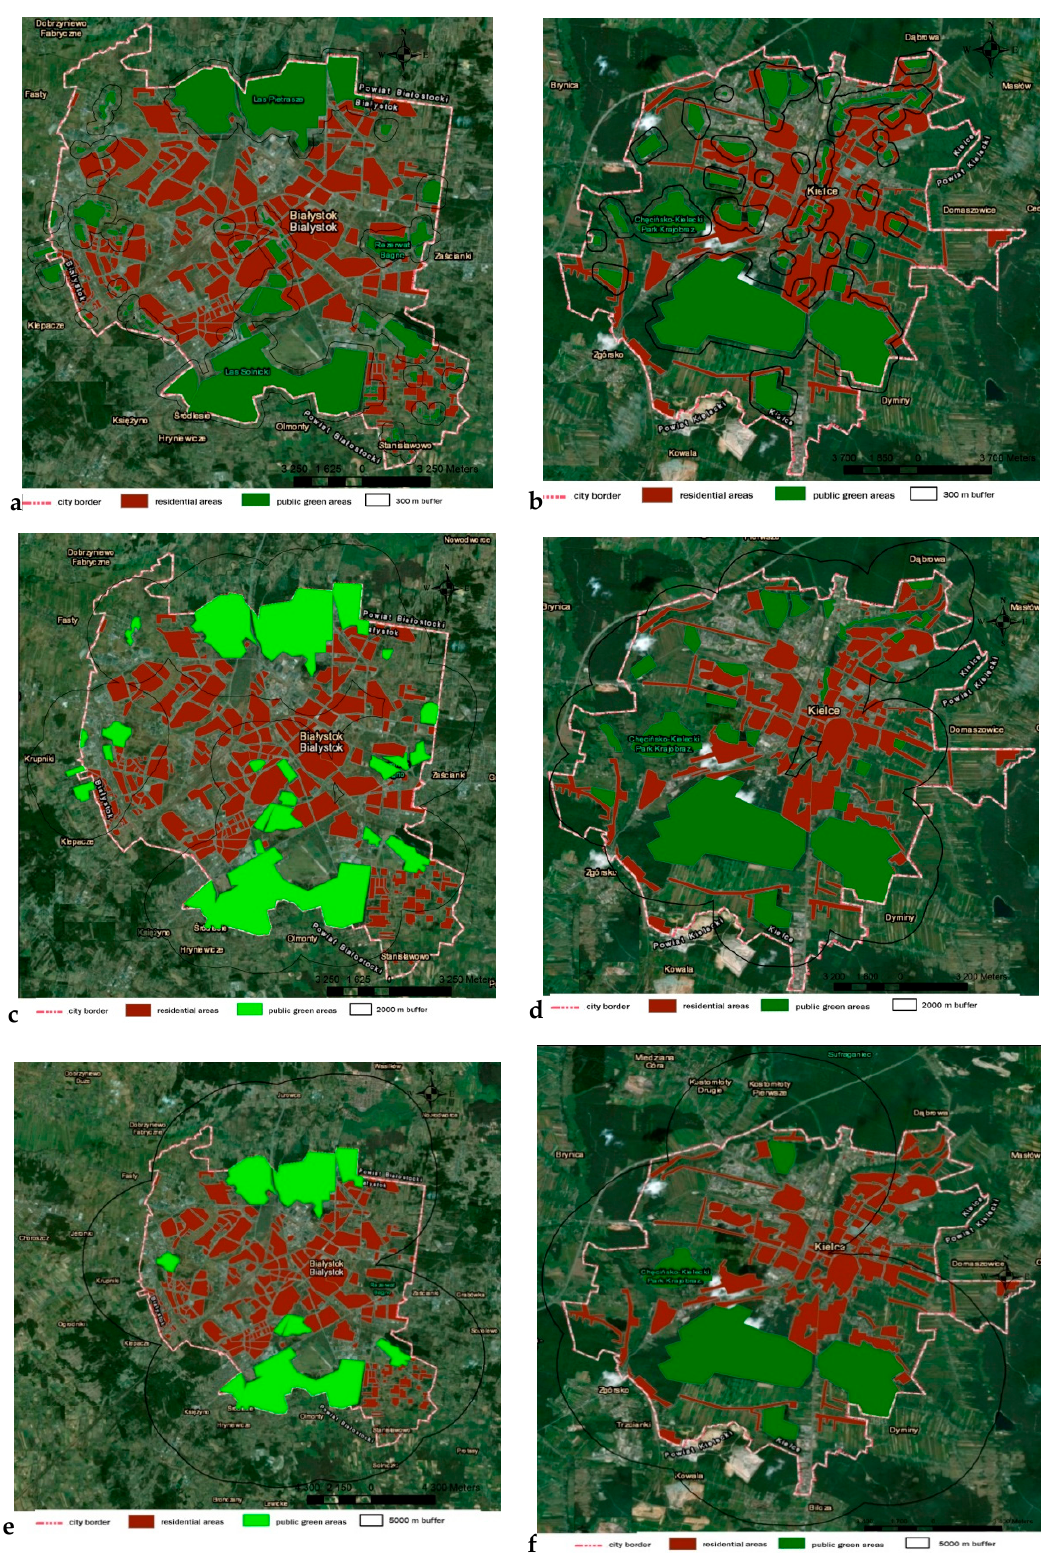
Figure 3. Access of residents to green spaces: ( a ) 300 m buffer in Bia ł ystok, ( b ) 300 m buffer in Kielce, ( c ) 2 km buffer in Bia ł ystok, ( d ) 2 km buffer in Kielce, ( e ) 5 km buffer in Bia ł ystok, and ( f ) 5 km buffer in Kielce.